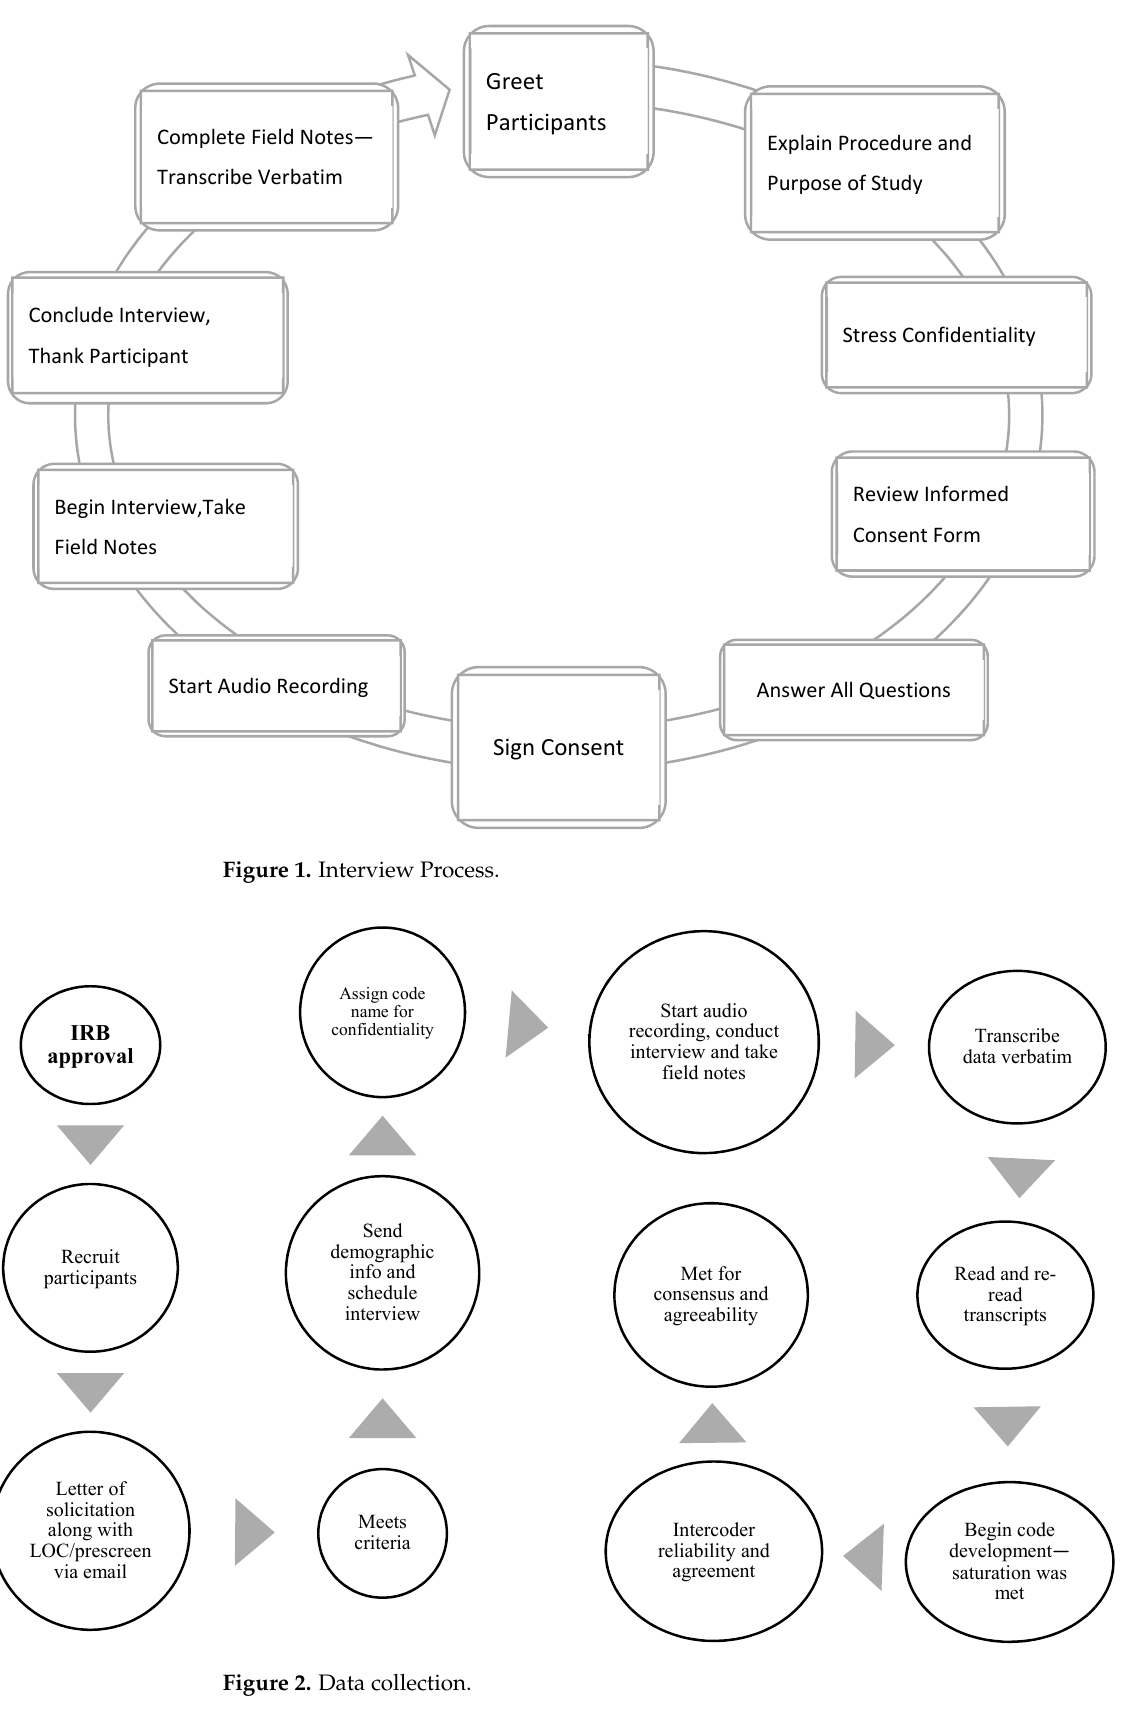
transcriptions. Figure 1 exemplifies the interview procedure, and Figure 2 illuminates the steps used for data gathering, starting with the Institutional Review Board (IRB) consent.